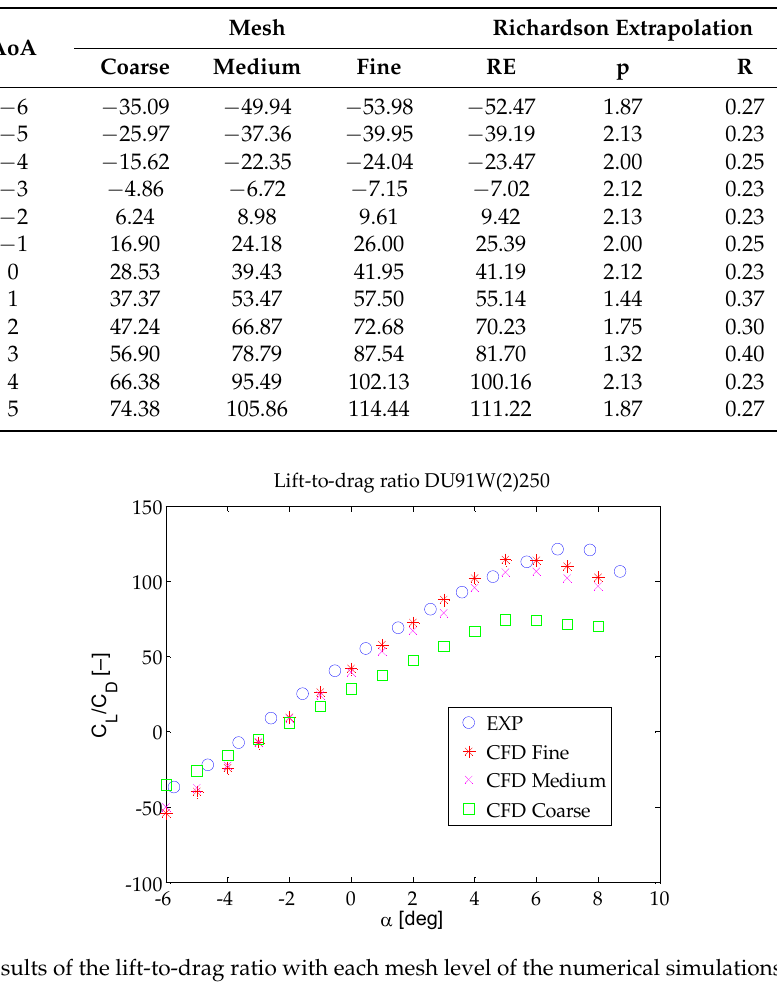
Table 1. Mesh dependency study results.